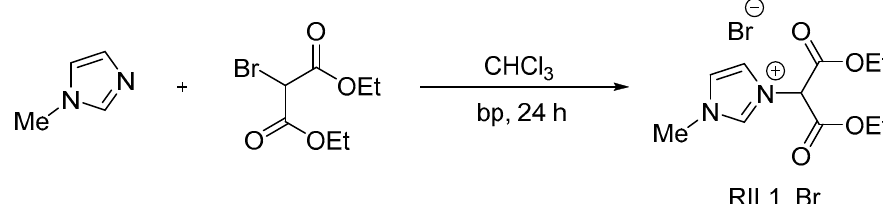
Figure 1. Scheme of 3-(1,3-diethoxy-1,3-dioxopropan-2-yl)-1-methyl-1H-imidazol-3-ium bromide (RIL1_Br) synthesis.